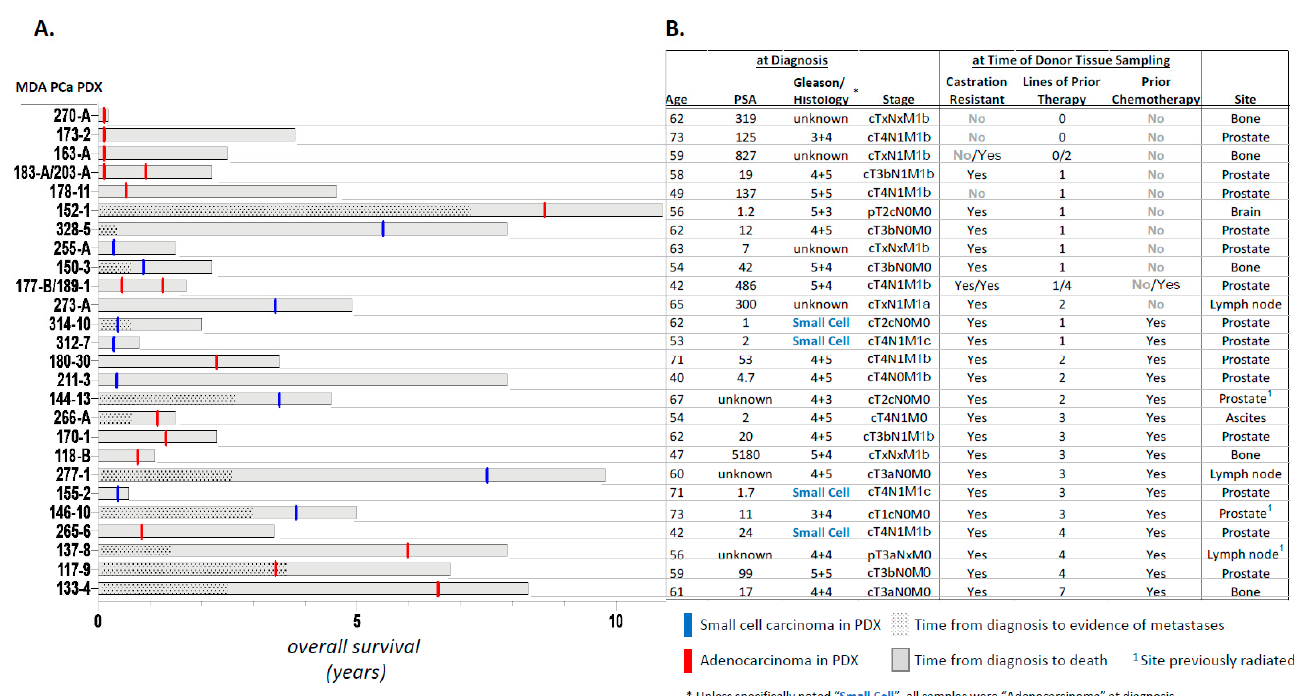
Figure 1. The 28 patient-derived xenograft (PDX) models of human prostate cancer used in this study. ( A ). Clinical course of the tumor tissue donors represented as a function of overall survival, along with morphology at the time of donor tissue retrieval (adenocarcinoma vs. small cell carcinoma). Also shown is time from diagnosis to evidence of metastasis. ( B ). Shown are age at diagnosis, PSA, Gleason score and tumor stage (as available), castration resistance, information on prior therapy and site of donor tissue for the 28 PDXs.